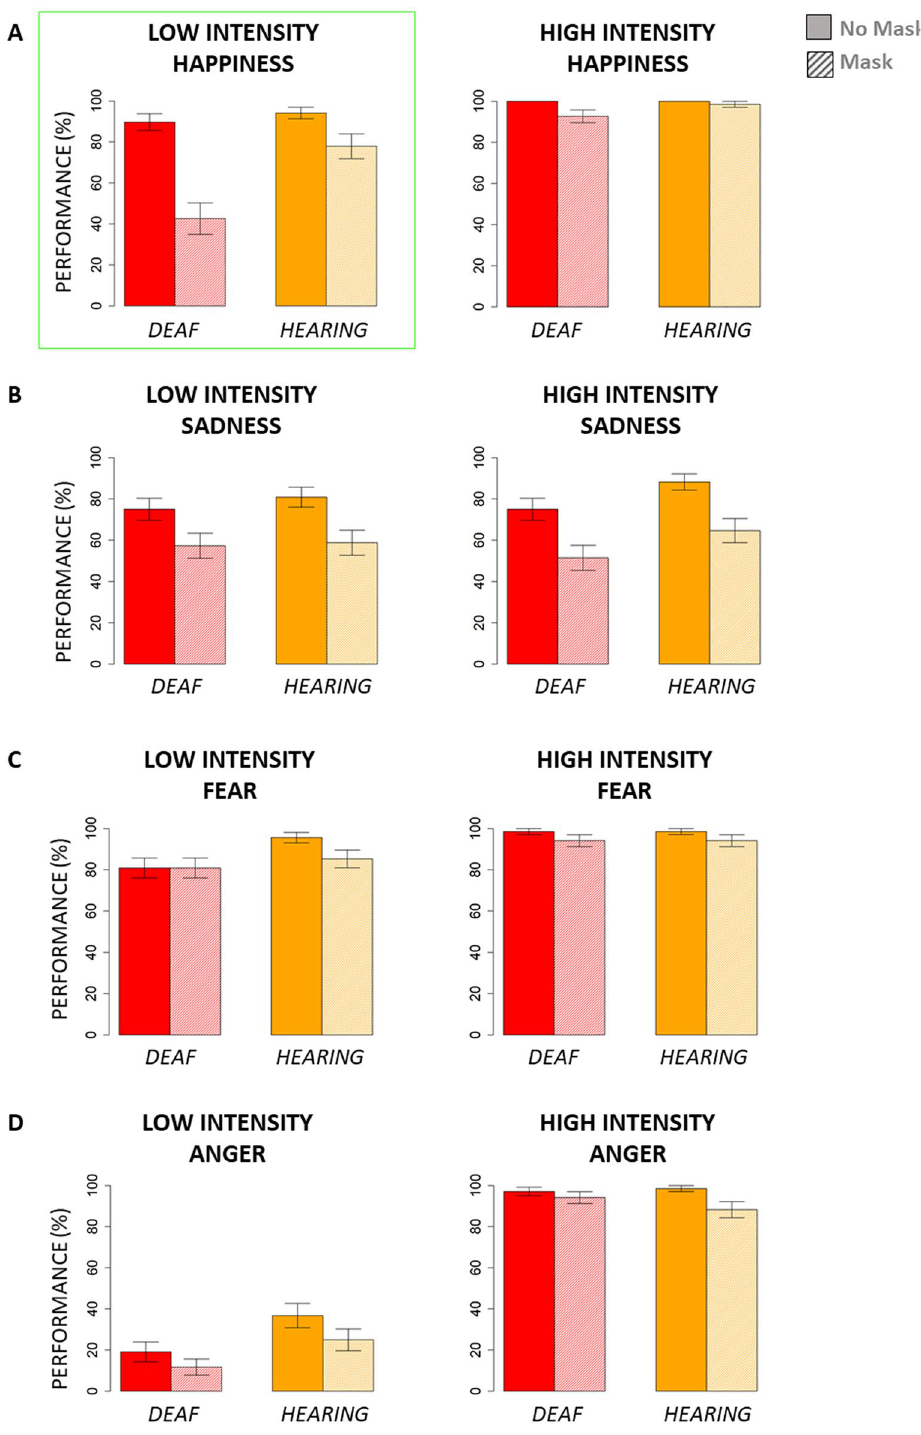
Figure 3. Percentage of correct responses without and with face masks in deaf and hearing people. Left: performance for images with a low level of intensity. Right: performance for images with a high level of intensity. ( A ) performance for happiness; ( B ) performance for sadness; ( C ) performance for fear; ( D ) performance for anger. The standard error of the mean (SEM) is